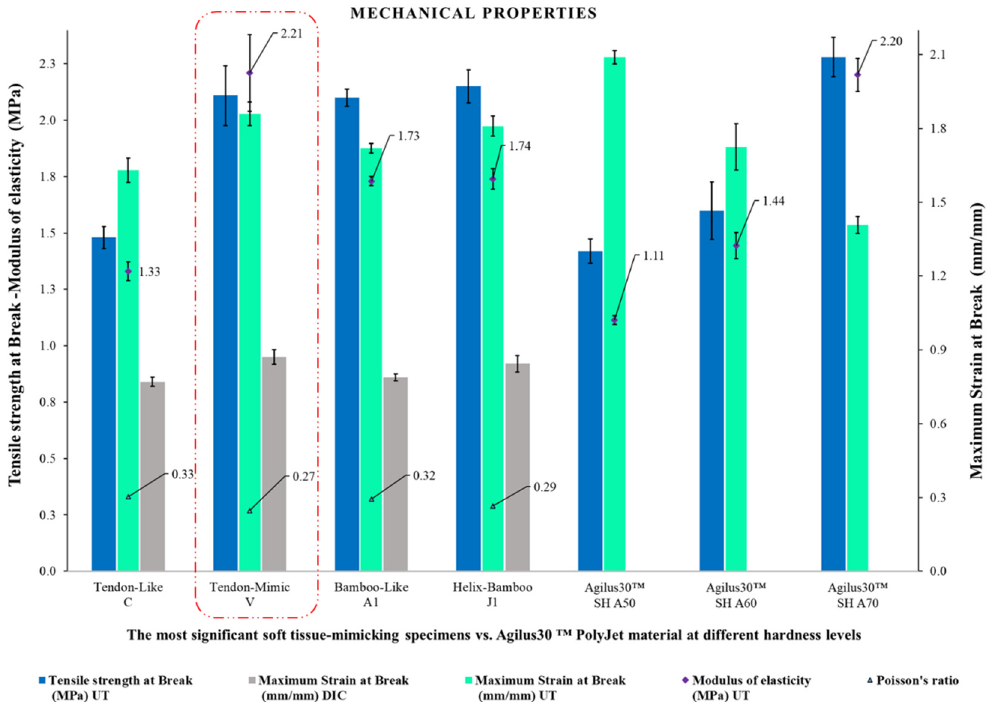
Figure 16. Comparison between the mechanical parameters (modulus of elasticity, tensile strength at break, maximum strain at break measured by UT and DIC, and Poisson’s ratio) of the specimens C, V, A1, and J1, and base PolyJet material Agilus30™ at different Shore A hardness levels, DIC measurements were not performed for base PolyJet polymers.